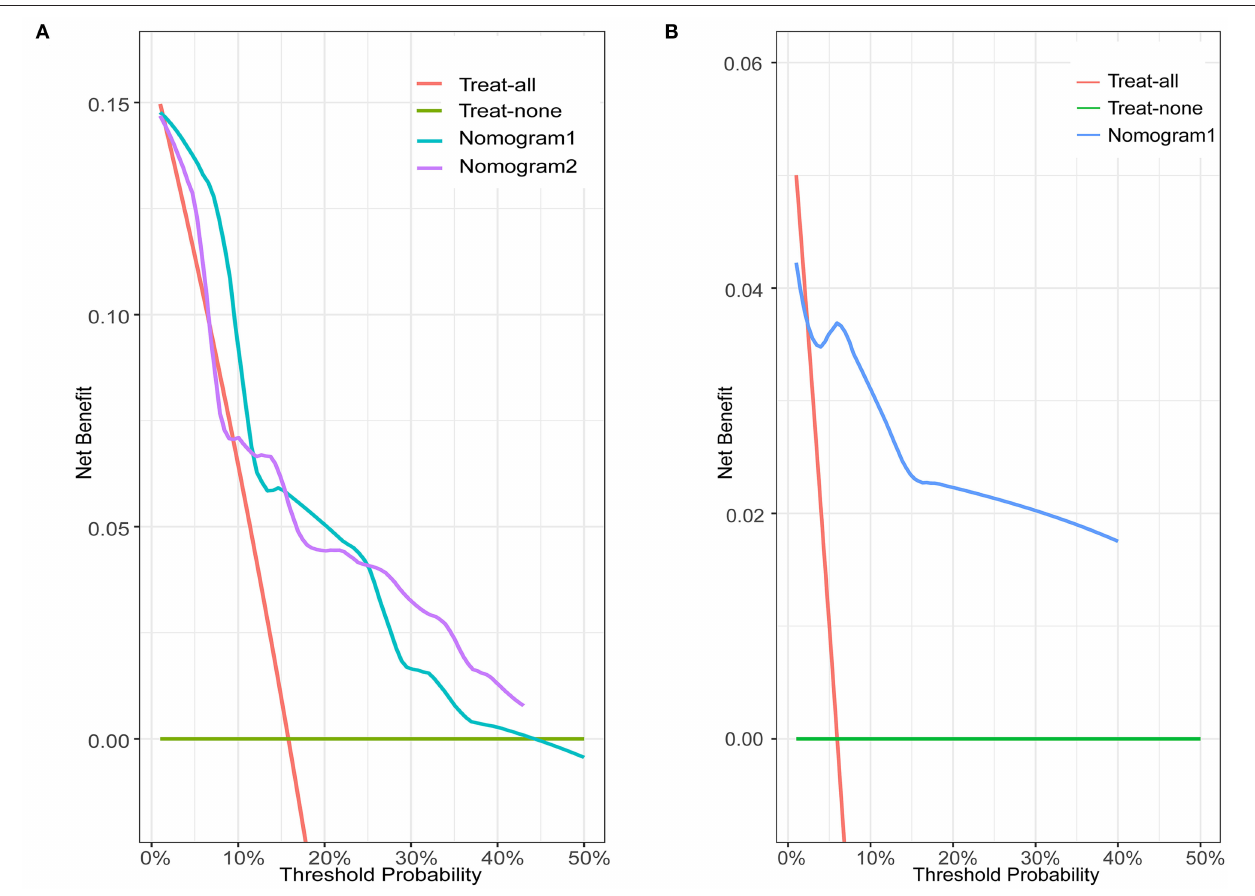
FIGURE 6 | Decision curve analysis for nomograms in the training and validation sets. Green horizontal line: treat-none patient protocol (representing no clinical benefit). Red line: treat-all patient protocol (representing the highest clinical cost). (A) Blue line: training set of nomogram 1. Purple line: training set of nomogram 2. (B) Blue line: validation set of nomogram